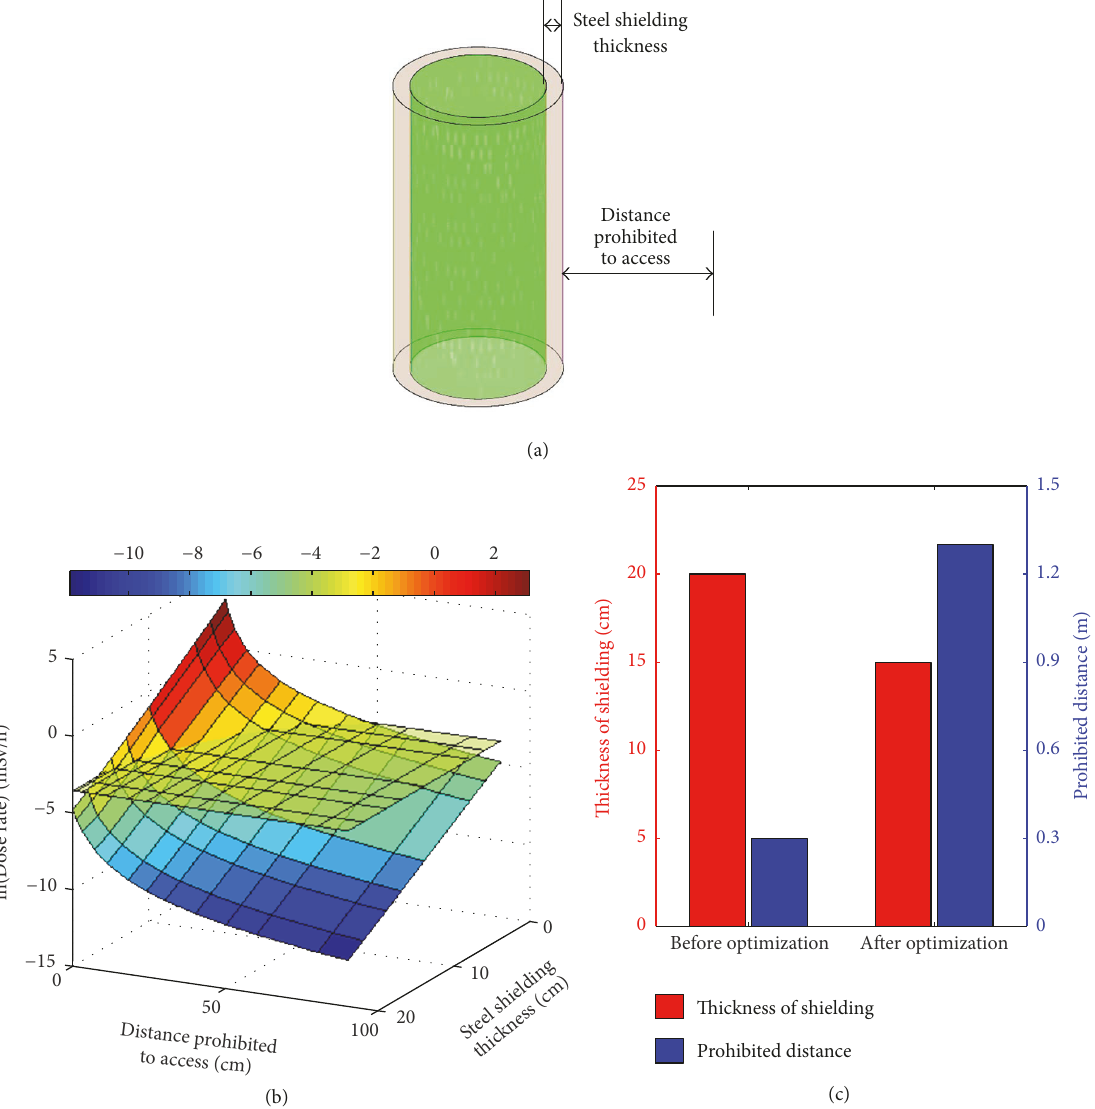
Figure 6: (a) Sketch of the graphite sphere cask; (b) the dose limit plane (0.03 mSv/h) and the dose rate contour of the graphite sphere storage cask with respect to distance and the thickness of shielding; (c) the dose rate and prohibited distance before and after